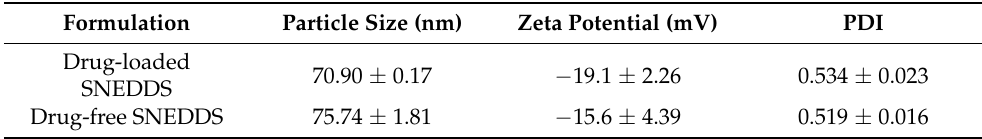
Table 2. Droplet size, polydispersity index, and zeta potential values of the drug-loaded and drug- free